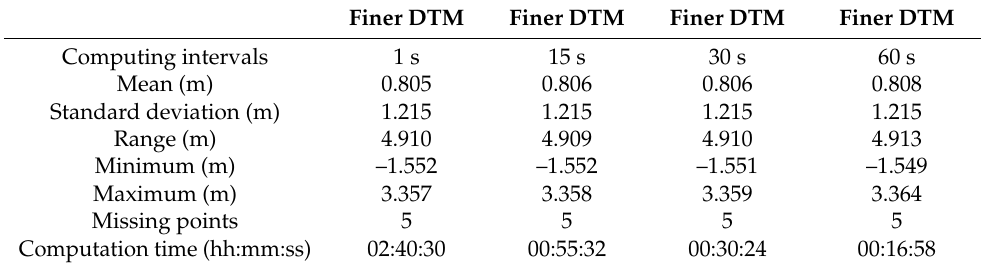
Table 2. Descriptive statistics of the residuals between the 82 validation points and their correspond- ing points in the HEC-RAS simulation with the finer DTM (0.50 m). Finer DTM Finer DTM Finer DTM